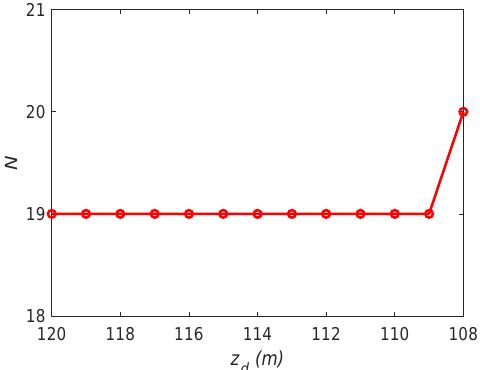
Figure 6. The number of drones N versus z d